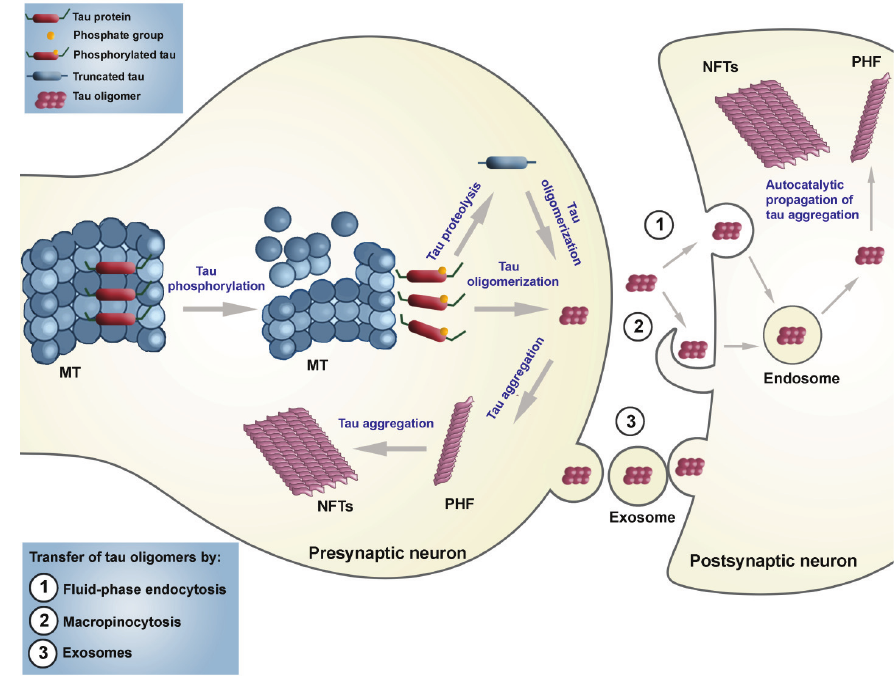
Figure 6. Schematic representation of three different ways of anterograde spreading of tau aggregates by endocytosis, macropinocytosis, and exosomes.